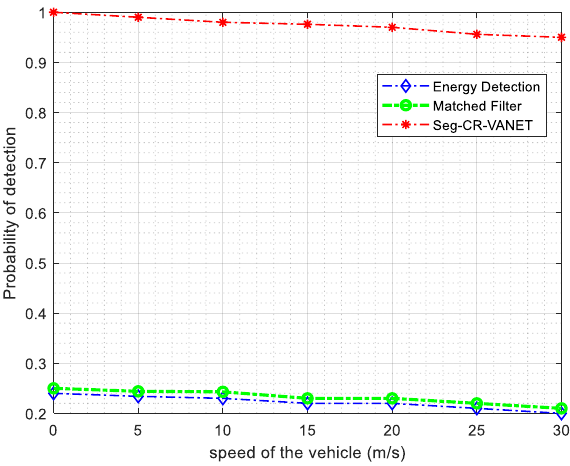
Figure 6. Probability of detection analysis.